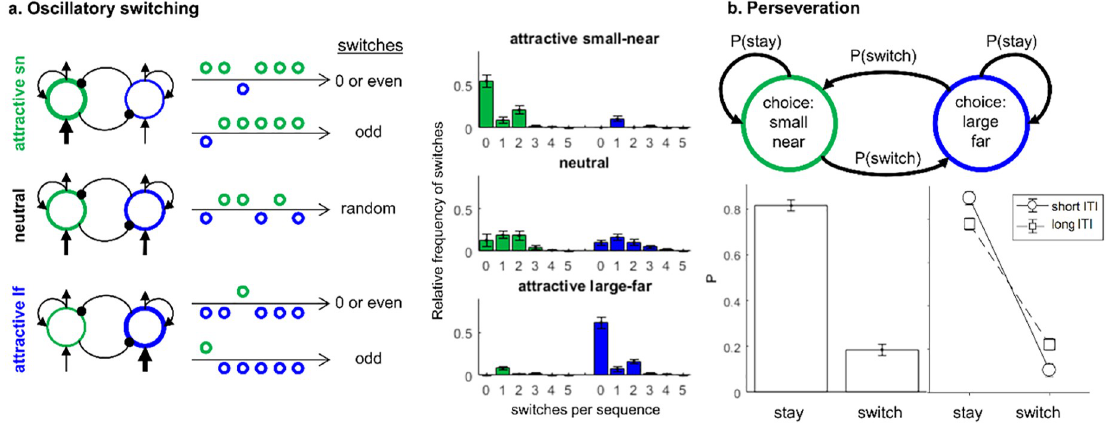
Fig 2. Model predictions for sequences of repeating decision situations. a) The model predicts patterns of oscillatory switching that depend on the options’ attractiveness and the initial choice in sequences of choices. If the attractive option is chosen initially, the model predicts that zero (staying with the attractive option) or an even number of switches across the sequence are more likely than an odd number of switches. If the unattractive option is chosen initially, the model predicts one (switching back to the attractive option) or an odd number of switches. b) The model predicts choice perseveration as identified by markov analysis: Choosing an option in one trial leads to a higher probability of staying with this choice in the next trial. This perseveration effect is stonger for short inter trial intervals (ITI) than for long ITI. Error bars mark 95% confidence